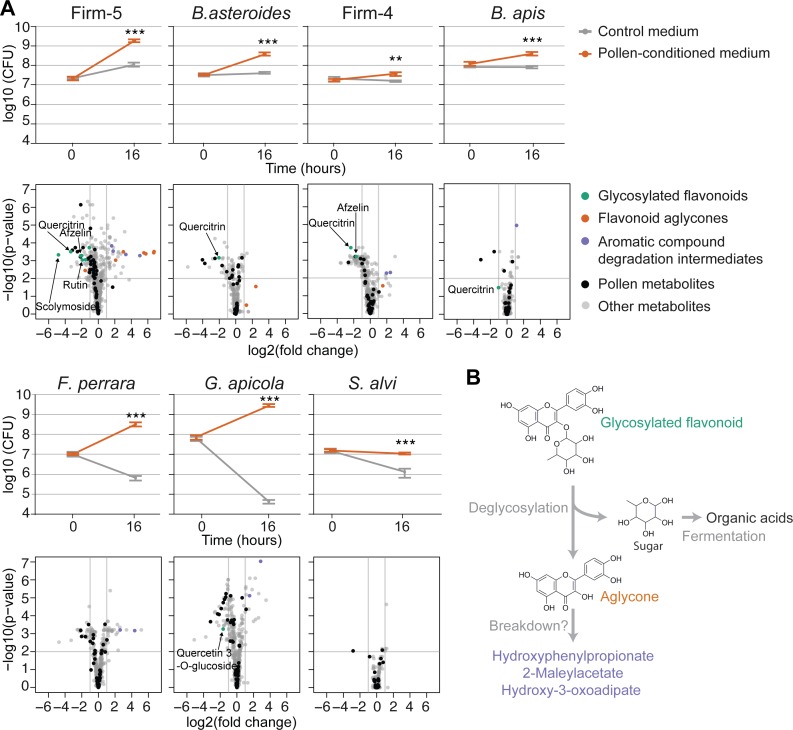
Recapitulation of flavonoid degradation patterns by gut bacteria during in vitro growth in pollen-conditioned medium.(A) Line graphs show the growth of each community member in control medium and pollen-conditioned medium based on colony-forming unit (CFU) counts at time points 0 h and 16 h. Values are the mean of five replicates, with error bars indicating standard deviation. **P < 0.01, ***P < 0.001 (Welch’s t test). Volcano plots of significance (Welch’s t test Benjamini and Hochberg adjusted [BH adj.] P value) versus log2(fold change) show metabolic changes in pollen-conditioned medium at time point 16 h relative to 0 h. Ions identified as pollen derived are highlighted in black. Ions annotated as glycosylated flavonoids, flavonoid aglycones (non-glycosylated flavonoids), or putative flavonoid breakdown products are shown in color when they displayed log2(fold changes) ≥ |1|. Other annotated ions are plotted in grey. (B) Model for the metabolism of flavonoids in the bee gut. Flavonoids are deglycosylated by specific bee gut bacteria, resulting in the release of flavonoid aglycones. The sugar residues are likely fermented into organic acids. Accumulation of several intermediates of aromatic compound degradation pathways, both in vivo and in vitro, suggests that the aglycone may be broken down further. The numerical values of the line graphs and the volcano plots can be found in S1 Data and S9 Data, respectively.